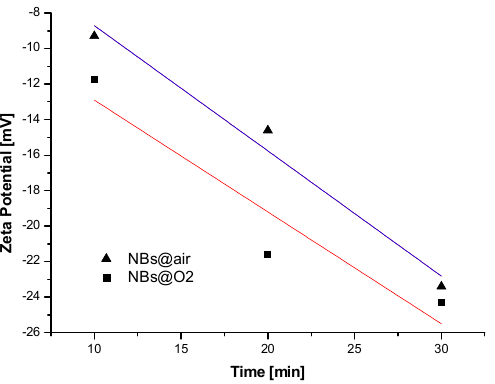
Figure 6. Kinetic experiments for the adsorption of Pb(II) onto activated carbon with and without nanobubbles in water. Reprinted with permission; copyright Elsevier [70].